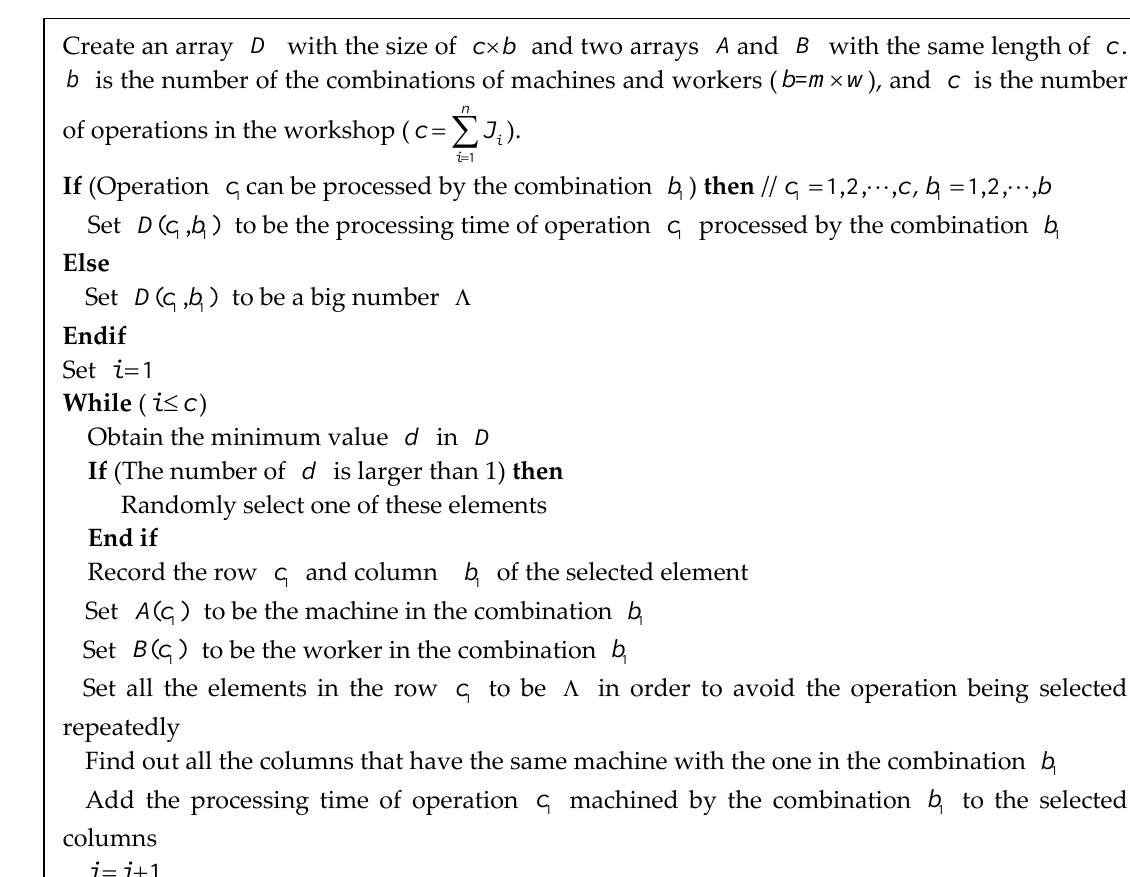
Figure 2. Pseudo-code of the modified assignment rule (MAR).